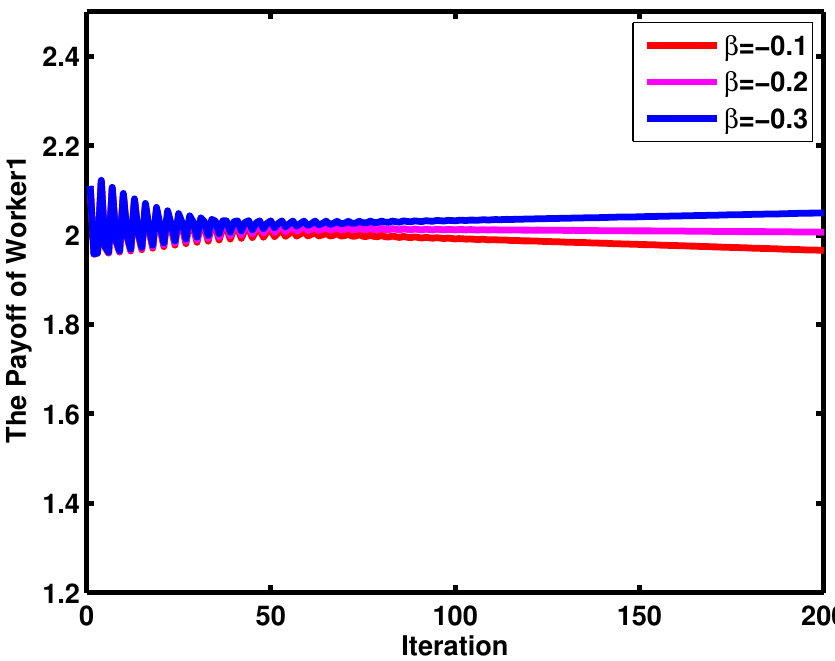
Figure 6. The payoff of worker 1 using ZD2 strategies with different β